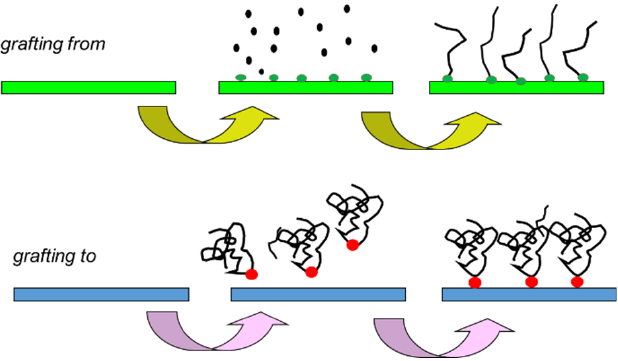
Figure 3. Different synthesis of smart surface possibility: “grafting to” and “grafting from”.